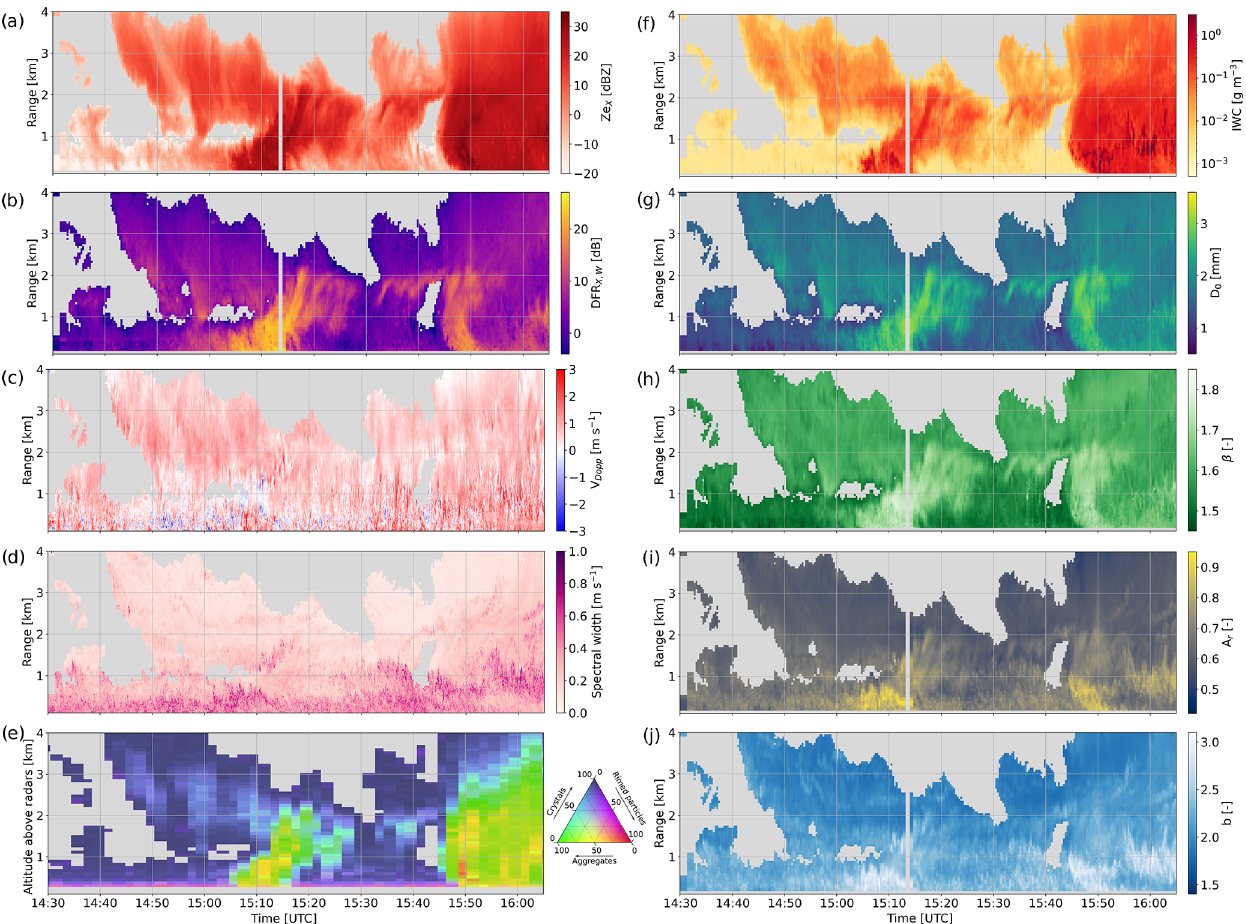
Figure 5. Height–time plots of radar measurements and microphysical retrievals. The left panels contain radar data: (a) Ze X ; (b) DFR XW ; (c) W-band mean Doppler velocity; (d) W-band spectral width; and (e) time series of hydrometeor classification with demixing showing the proportion of the three main particle types identified – here, aggregates, rimed particles, and crystals (see Sect. 3.3). The right panels feature microphysical retrievals: (f) ice water content, (g) size parameter D 0 , (h) area–size exponent β a , (i) aspect ratio A r , and (j) mass–size exponent b m